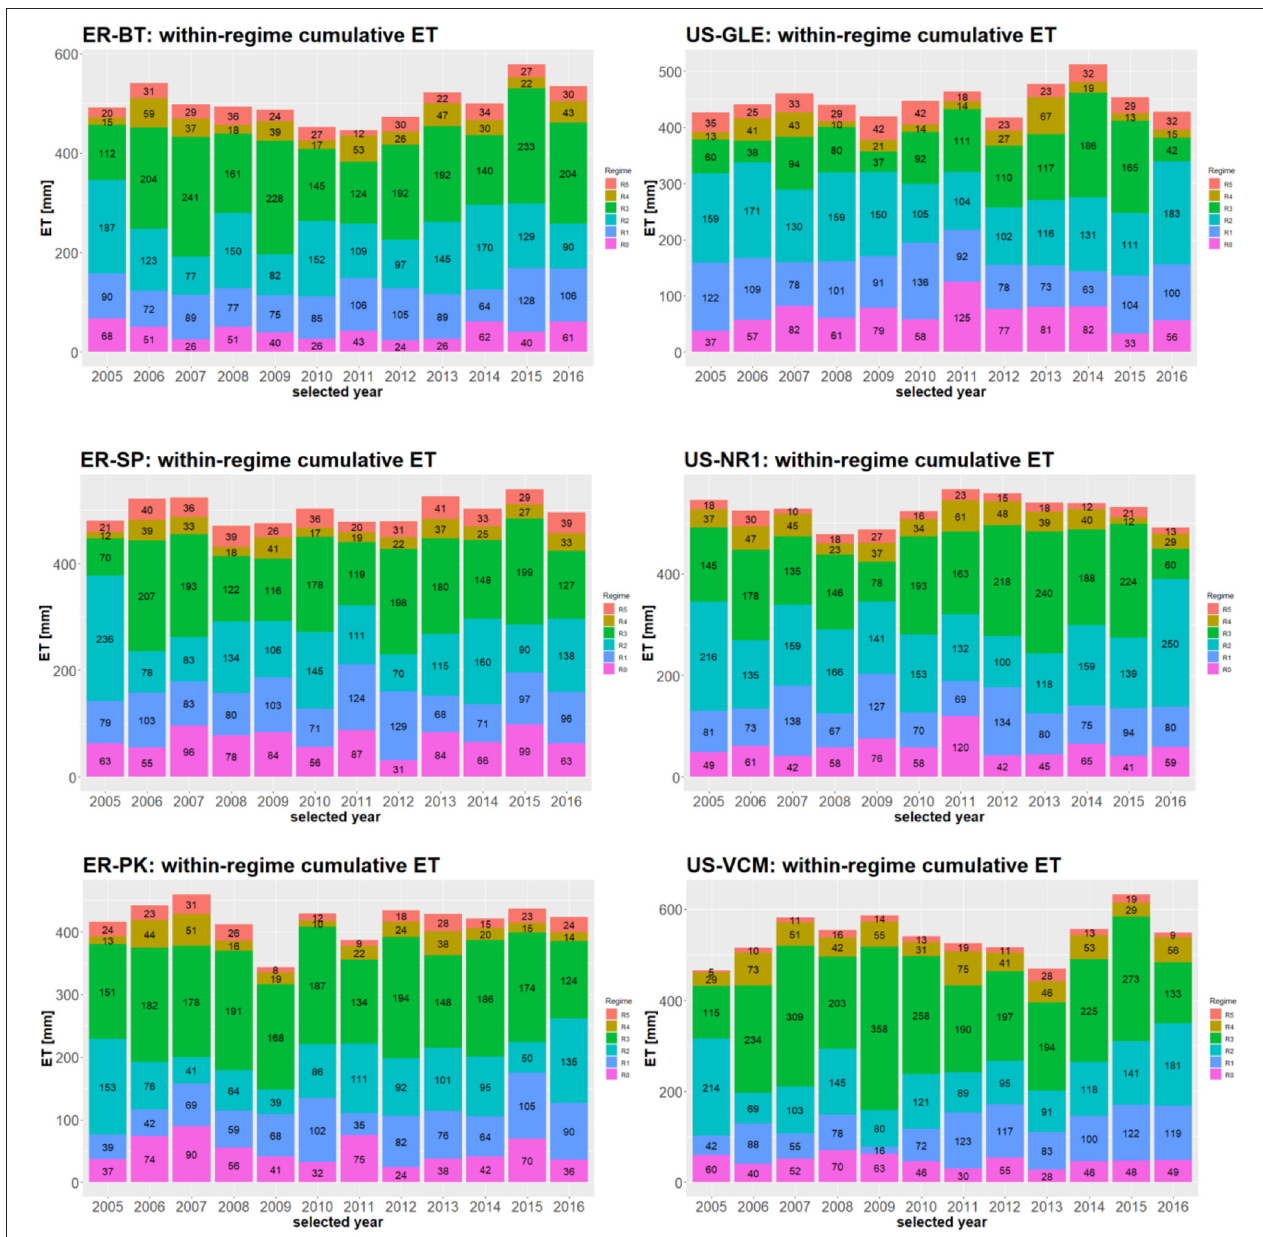
FIGURE 6 | Subseasonal regime dependent partitioning of ET. Numbers within each column represents the amount of within-cumulative ET.